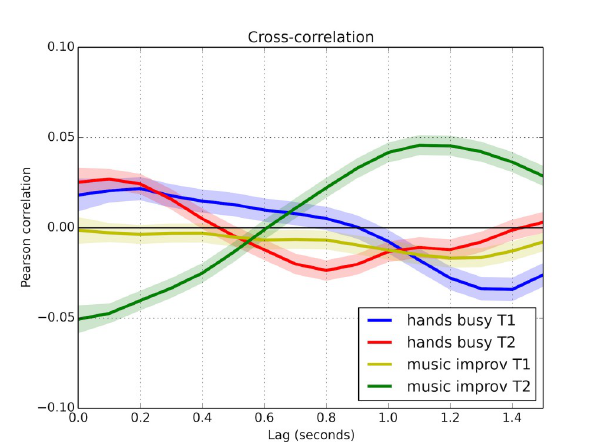
Fig 3. Aggregated cross-correlation curves for hands-busy and music improvisation groups in two different conversation moments: Before (T1) and after (T2) the joint activity. Shading represents Bonferroni-corrected 99.99% confidence intervals. A statistically significant difference of p < 0.0001 is implied when shaded areas of two curves do not touch or overlap at a given time.